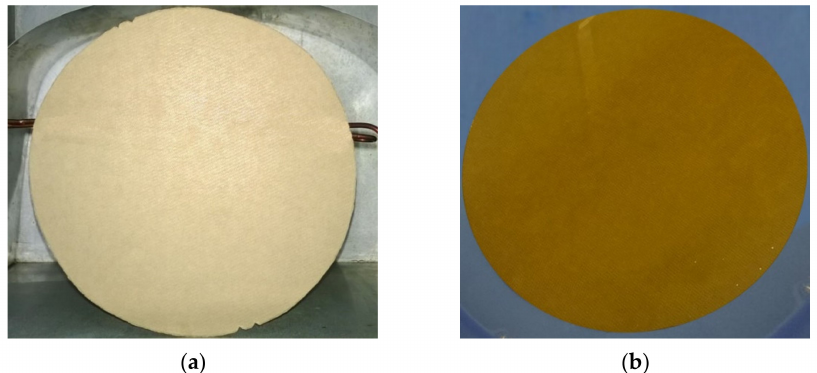
Figure 1. View of the test sample before moistening ( a ) and after moistening, drying and impregnation with insulating oil ( b ).